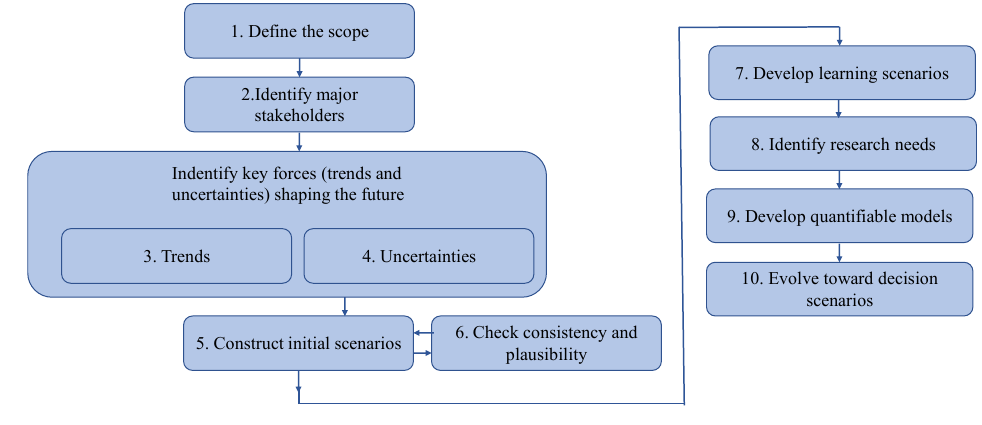
Figure 1. The scenario planning process